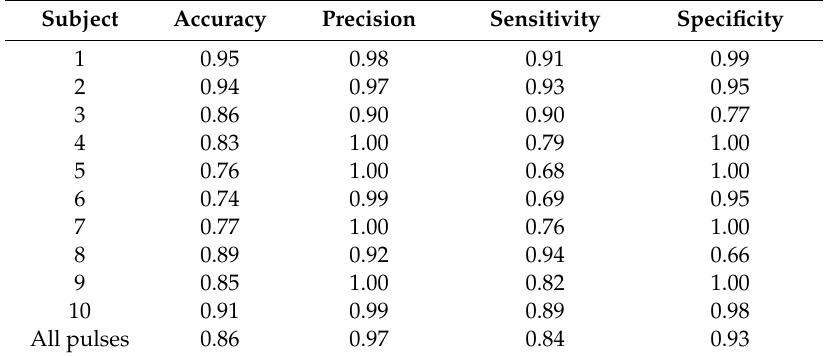
Table 8. The statistic results for the PPG pulses with the low SQIs for the individual subject and the total